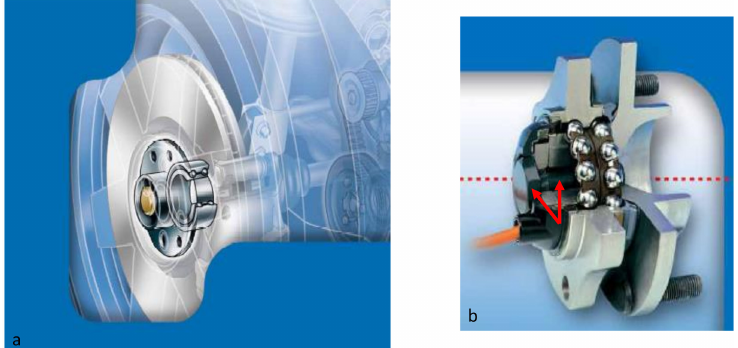
Figure 1. Hub Bearing Units (HBU) in the automotive industry; ( a ) the location of a HBU with respect to the vehicle wheel and suspension; ( b ) a cross section of the HBU showing the bearing component and the rivet holding all units